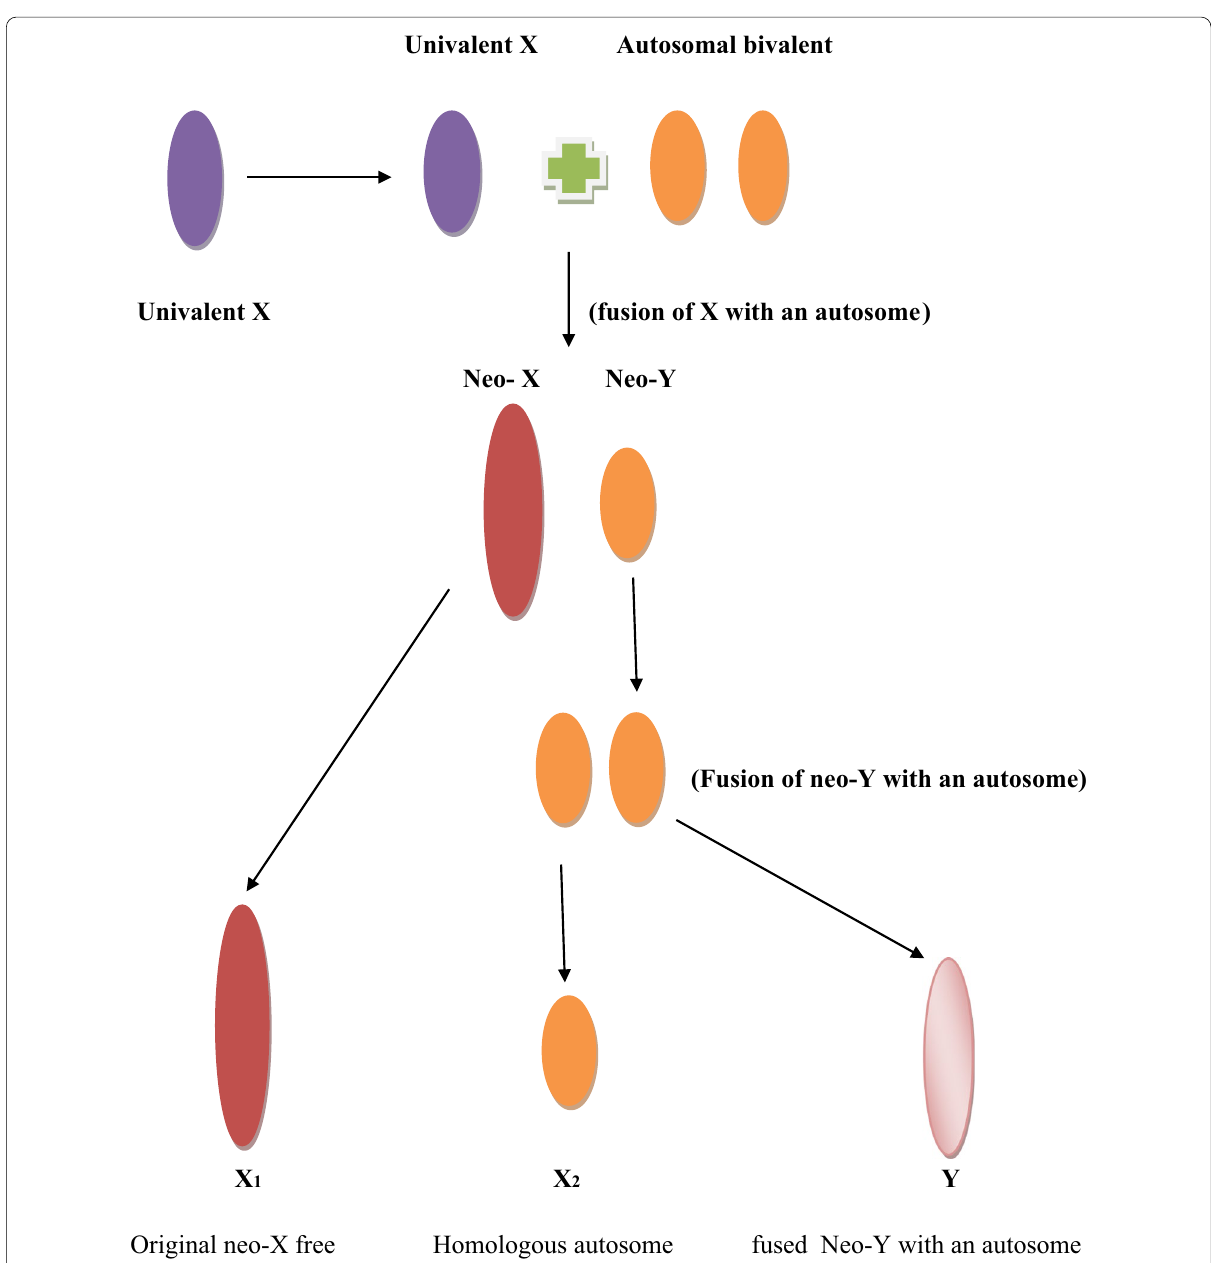
Fig. 3 Representation of X1X2Y sex determining mechanism in Micrathyria ungulata given by Mola et al.